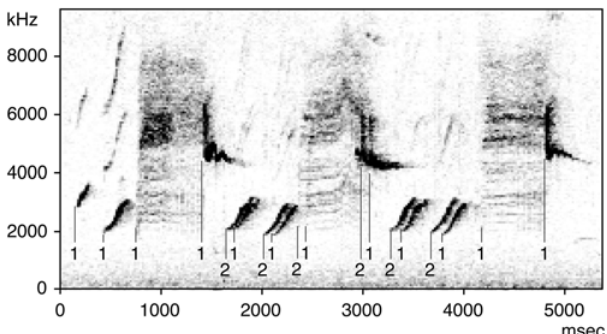
Figure 1. The unison duet of the forest weaver. We show a sonogram of a field recording of a breeding pair of forest weavers from Fannie’s Island. To better illustrate the fact that 2 animals are participating with the same syllable repertoire, we selected a duet in which bird 2 sings with a delay of about 90 msec. ‘‘1’’ and ‘‘2’’ indicate the onset of syllables produced by either bird. In many cases the animals duet with an offset of less than 10 msec.